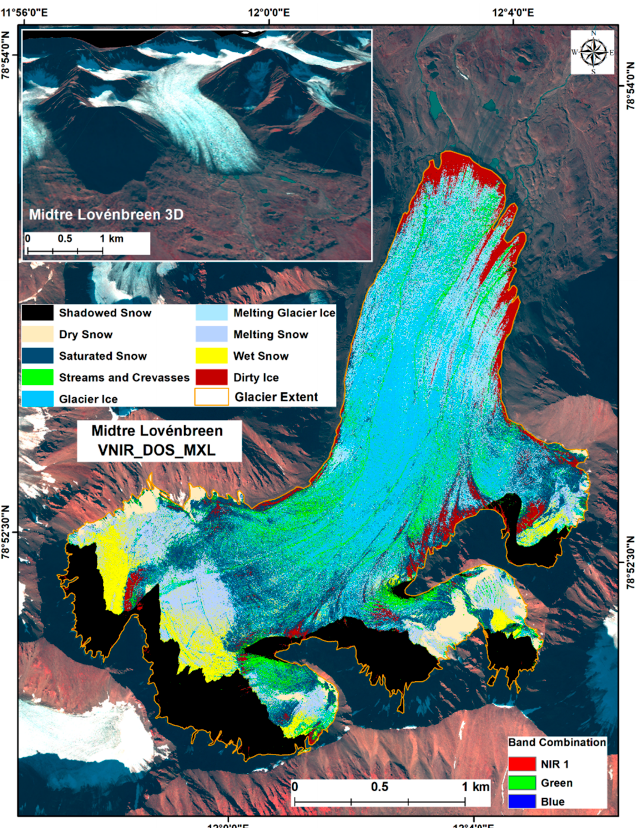
Figure 5. MXL classification of VNIR_DOS processing scheme of the ML glacier. Background image: WorldView-3 © 2016 Maxar.